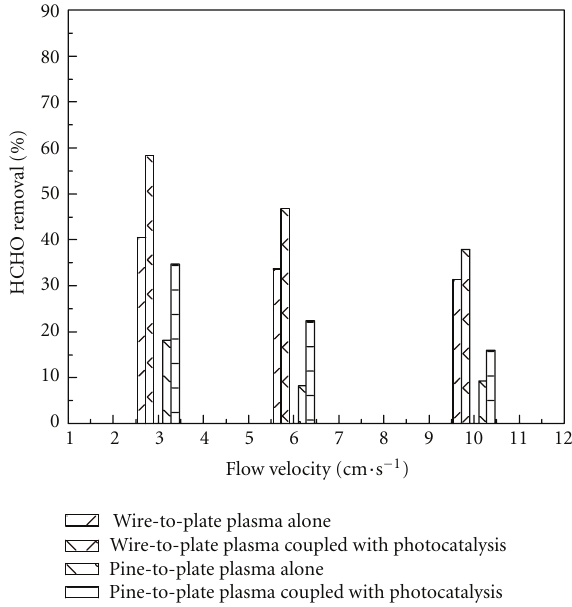
Figure 6: The removal of HCHO varies with flow velocity by di ff erent corona